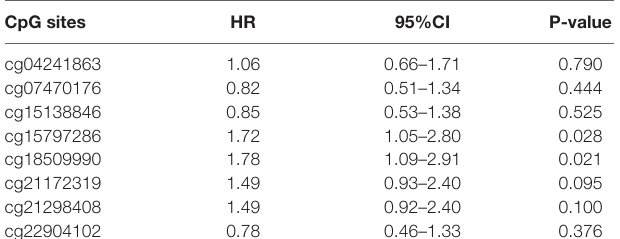
TABle 3 | Survival analysis of N - acetyltransferase 1 ( NAT1 ) CpG sites combine with mRNA expression in colon adenocarcinoma